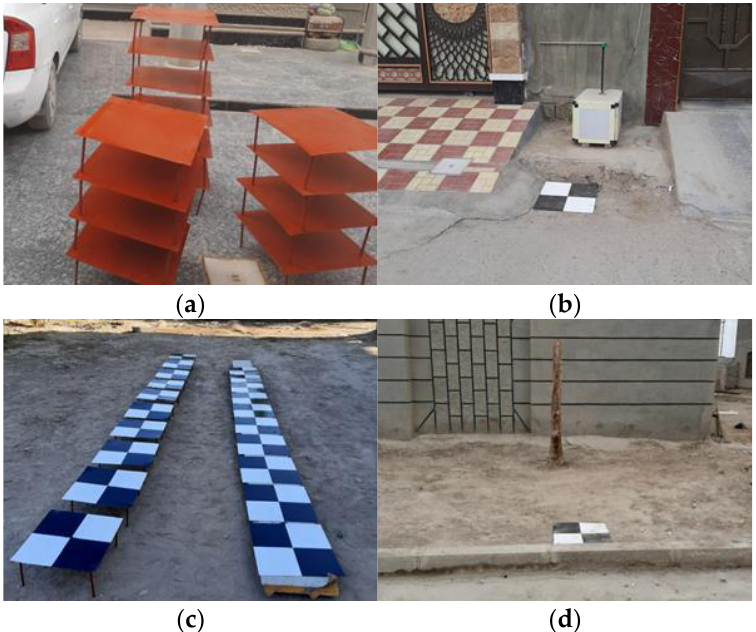
Figure 5. Preparation of GCPs and CPs. ( a ) initial iron sheets. ( c ) final Colored iron sheets. ( b , d ) samples of CPs.